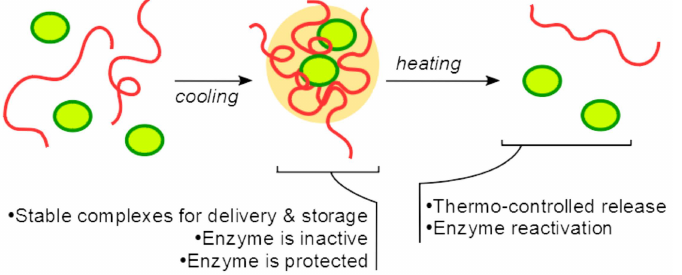
Figure 5. The scheme represents two key advantages of the suggested approach: simple preparation of the complexes with inactivated and protected enzyme and temperature-controlled release of the enzyme accompanied by its